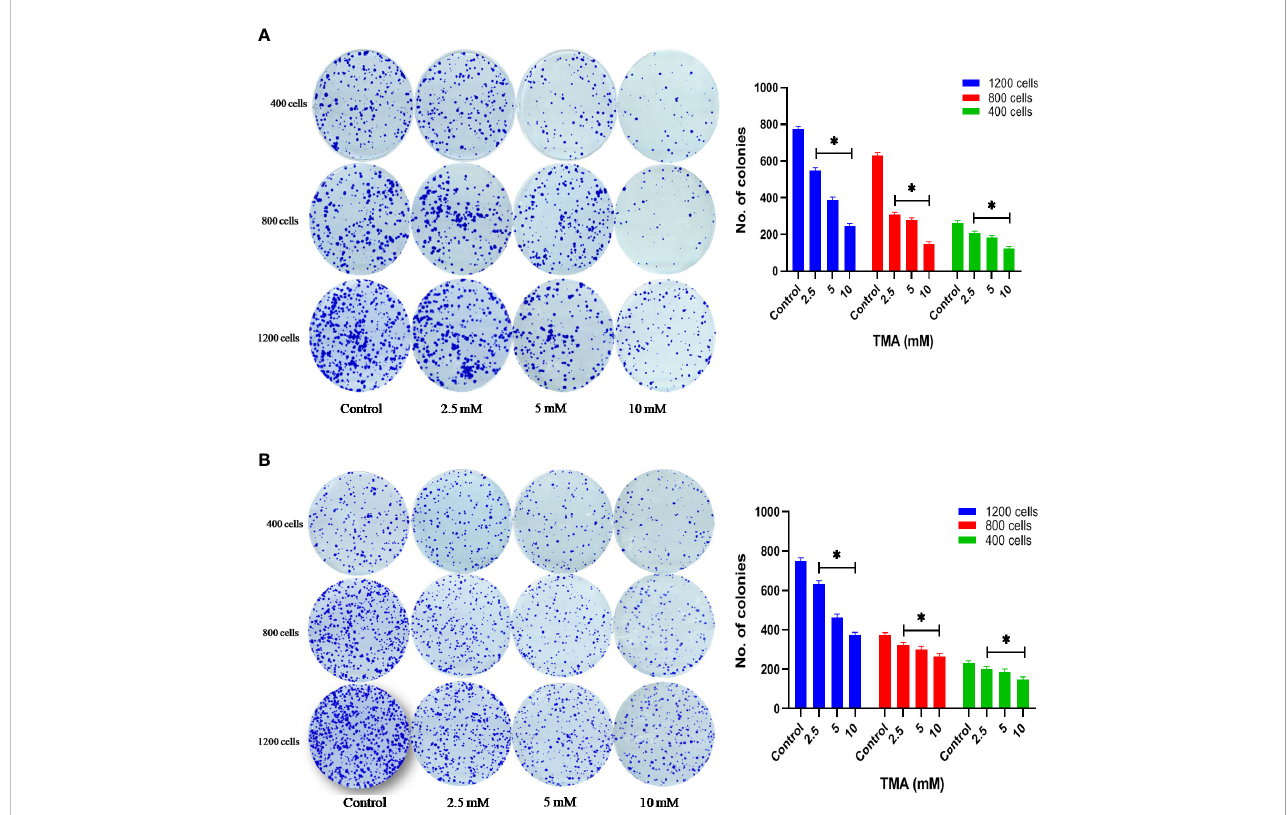
FIGURE 4 Clonogenicassay.TMAinhibitscolonyformationof (A) HCT116and (B) HT29cells.EvaluationofcolonyformingabilityinHCT116andHT29celllineexposedtovarious concentrationsofTMAfor48h.TMAinhibitsthecolonyformingabilityofHCT116inaconcentrationdependentmanner.Resultswereplottedasno.ofcoloniesformed after14days(shownrighttothecolonyimages).Negativecontrolcellsweretreatedwithcellculturewateronly.Differenceofaveragevaluesbetweenuntreatedand treatedcellsweretestedusingpairedstudent ’ st-test.Alltestedsubjectsshowedsigni fi cantdecreaseinviabilitywhile10mMTMAprovedmostcytotoxictocells.The results(mean±SEM)wereobtainedfrom3independentexperiments.*indicatessigni fi cantlydifferentvaluescomparedtocontrolgroup( P